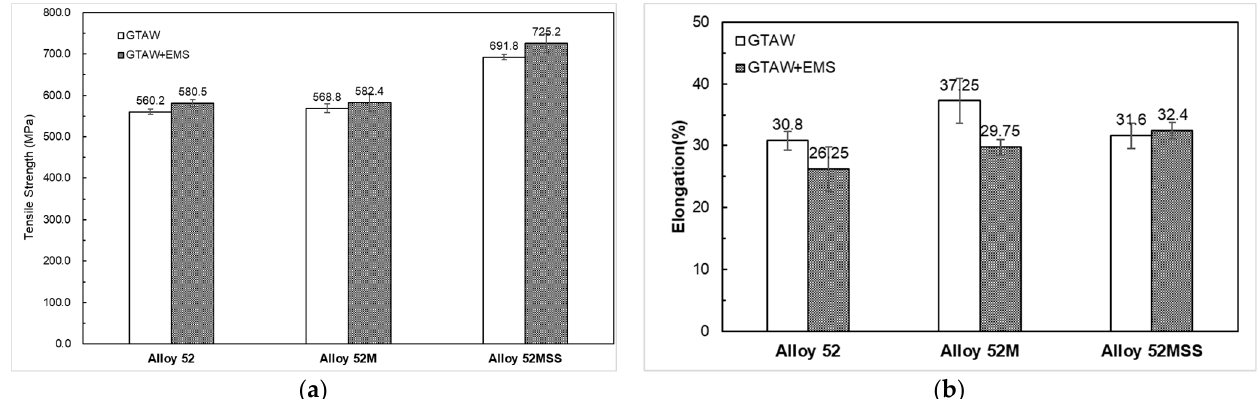
Figure 16. Average results of tensile tests: ( a ) tensile strength, and ( b ) elongation.